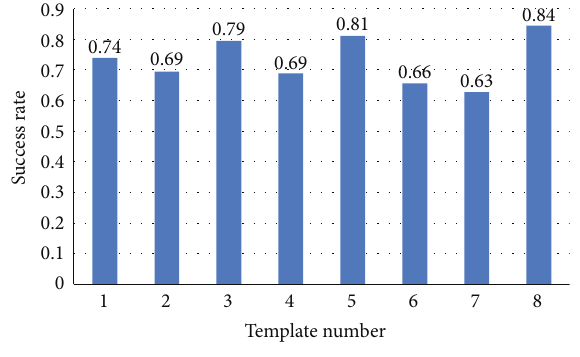
Figure 4: Least squares identification result.